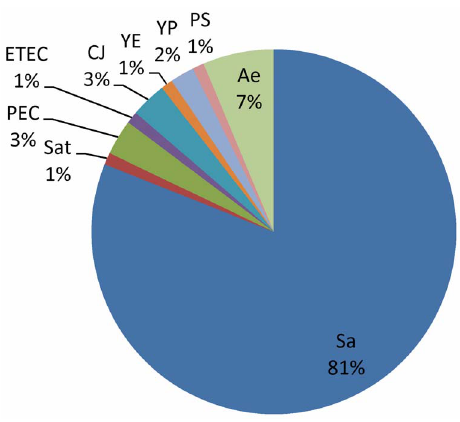
Figure 3. Etiological distribution of diarrhea syndrome in Guangxi, China, 2009–2011. Of 95 etiologies cultured from specimens of diarrhea syndromes: Salmonella (Sa,77), Salmonella-typhi (- Sat,1), Pathogenic Escherichia coli (PE,3), Enterotoxigenic Escherichia coli (ETEC,1), Campylobacter jejuni (CJ,3), Yersinia enterocolitica (YE,1), Yersinia pseudotuberculosis (YP,2), Plesiomonas shigelloides (PS,1), Aero- monas (Ae,6). doi:10.1371/journal.pone.0110876.g003 frequently isolated pathogens were non-typhoidal Salmonella (77,